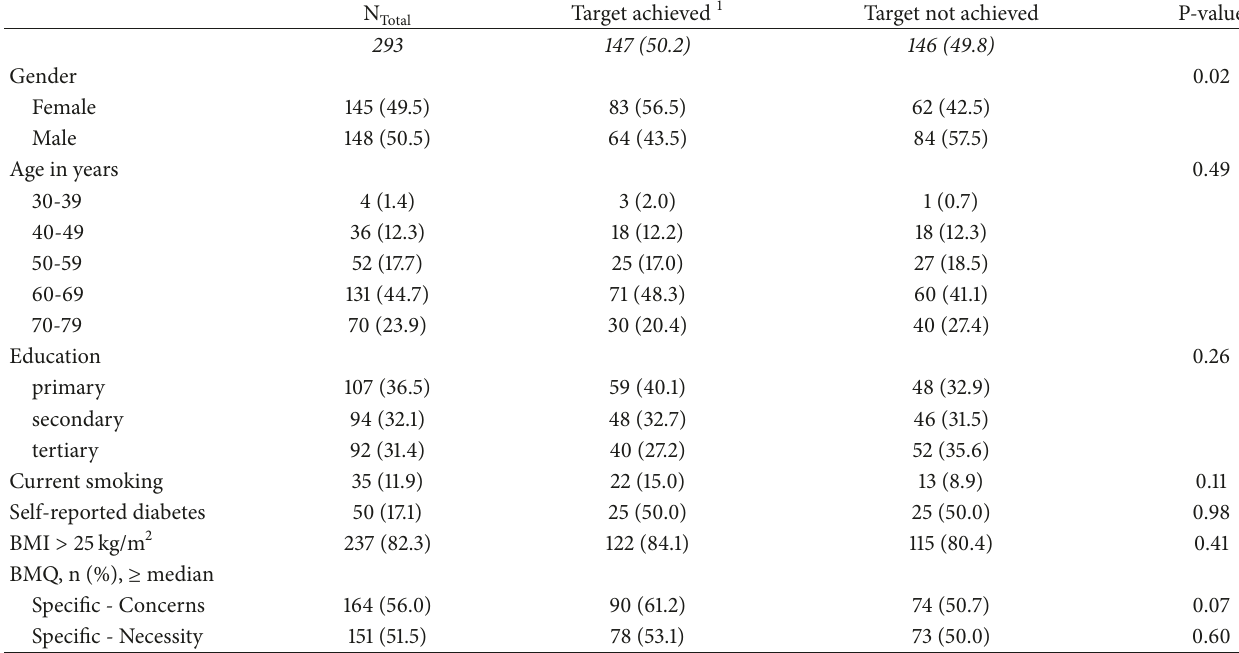
Table 1: Characteristics of the study population stratified according to achieved or not achieved recommended blood pressure